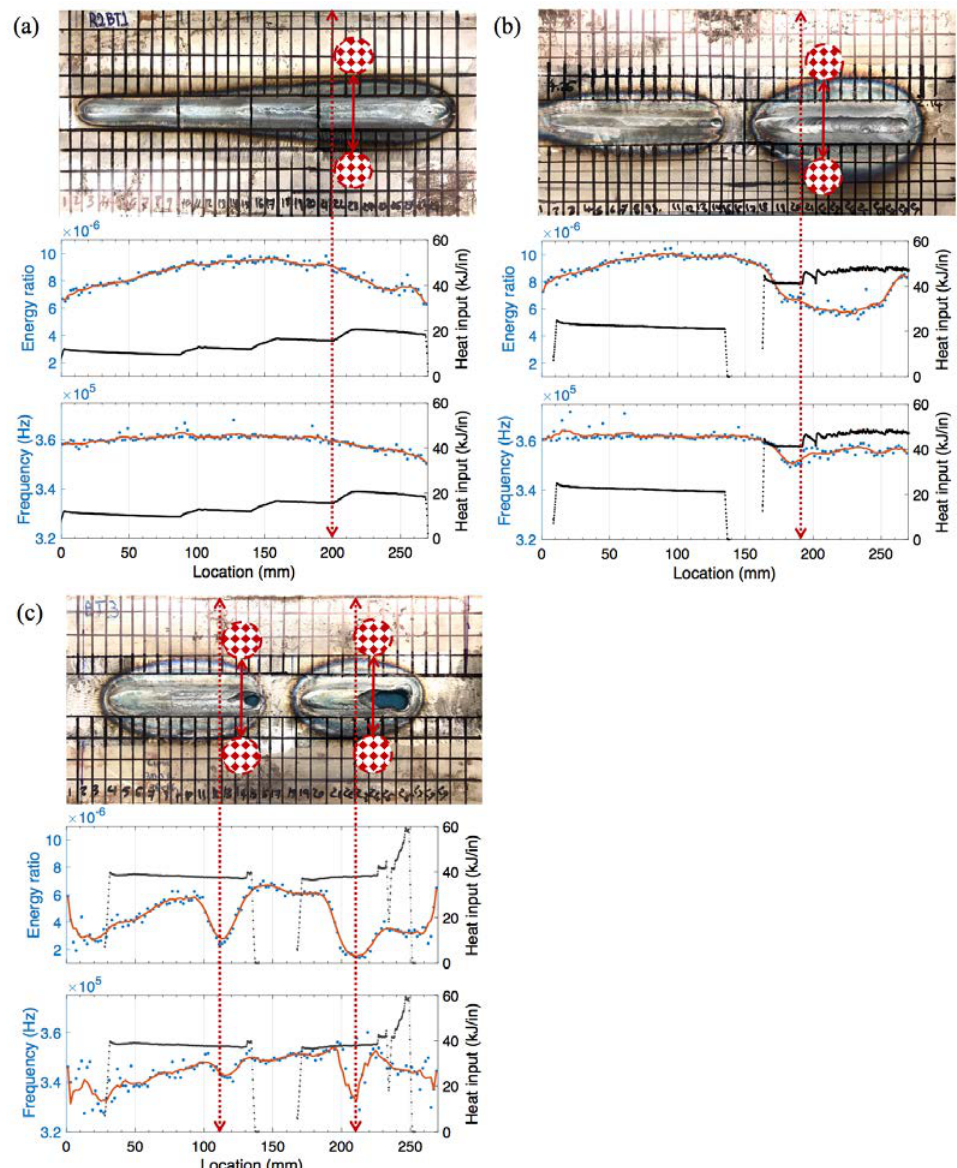
Figure 13. The correlation of UT features (energy ratio and peak frequency) and weld heat input with major changes in the weld microstructure corresponding to weld coupons ( a ) No. 1, ( b ) No. 2, and ( c ) No. 3, respectively.